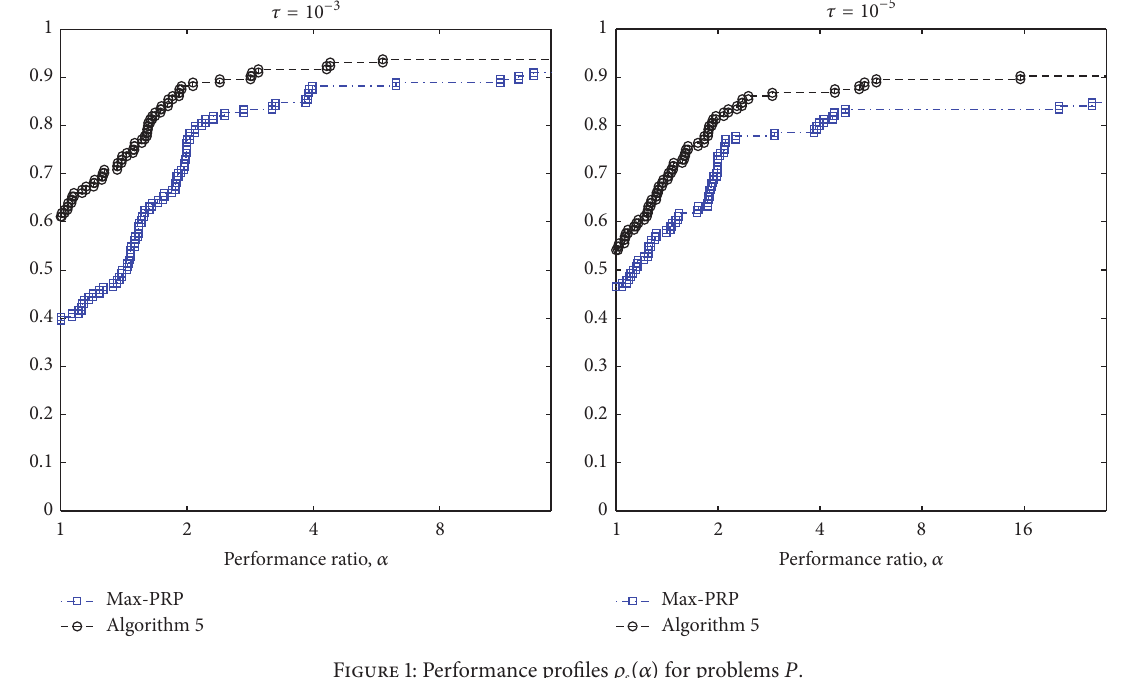
Figure 1: Performance profiles 𝜌 𝑠 (𝛼) for problems 𝑃 .